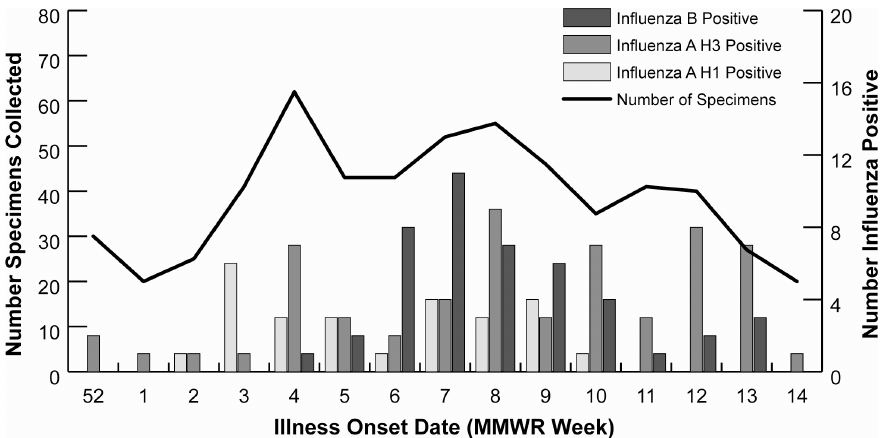
Figure 1. Number of specimens collected and number of influenza positive cases by week during 15 week period of influenza circulation a,b : the Household Influenza Vaccine Effectiveness (HIVE) study, Ann Arbor Michigan, 2010 – 2011 influenza season. Footnotes: a Week ending January 1, 2011 through week ending April 9, 2011. b 465 (32%) individuals from 193 (59%) households reported 605 acute respiratory illnesses and 580 (96%) specimens were collected. All specimens were tested for influenza viruses by reverse-transcriptase real-time polymerase chain reaction assay and 130 (22%) were determined to be positive for influenza, including 59 (45%) type A (H3N2), 44 (34%) type B, 26 (20%) type A (H1N1) pdm09 (pH1N1) and 1 (1%) type B/ type A (pH1N1) co-infection.